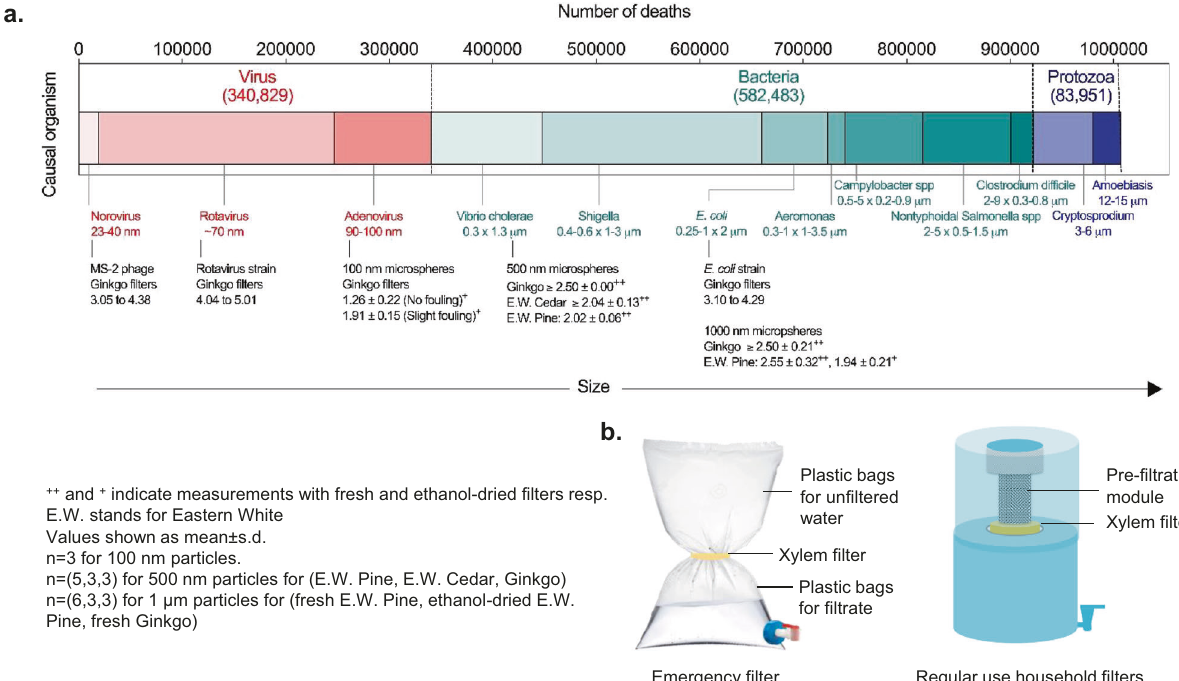
Fig. 7 Potential health impact and applications of xylem fi lters. a Comparison of diarrheal mortality burden due to different water-borne pathogens 2 arranged by size to the measured log rejection of particles of different size by single 0.375-inch-thick xylem fi lters (except for rejection experiments with 500-nm microspheres, where fi lter thickness was 0.25 inch) made from different tree species. Each n corresponds to a different fi lter. b Illustrations of possible con fi gurations of xylem-based fi ltration